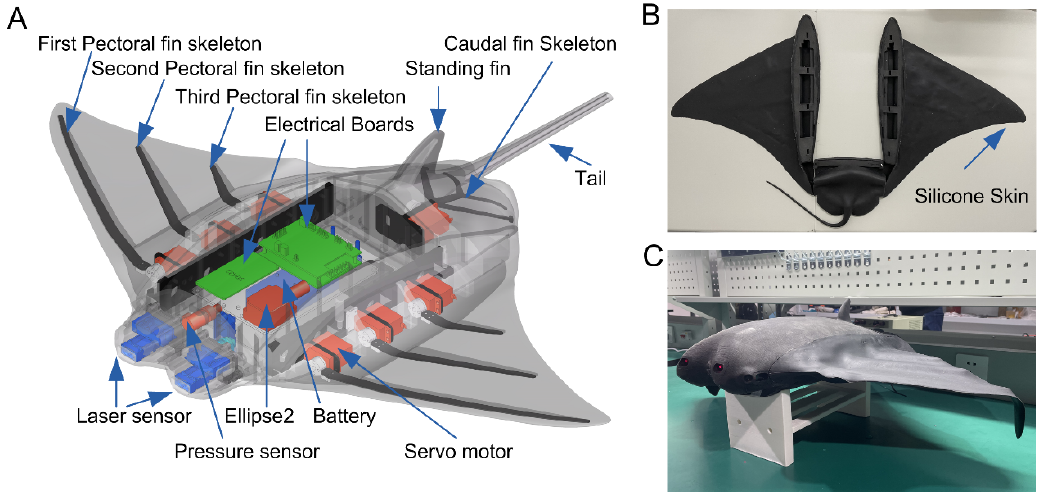
Figure 1. The structure of robotic manta. ( A ) The structure and electronics distribution of robotic manta. ( B ) Silicone pectoral and caudal fins. ( C ) Prototype of robotic manta.